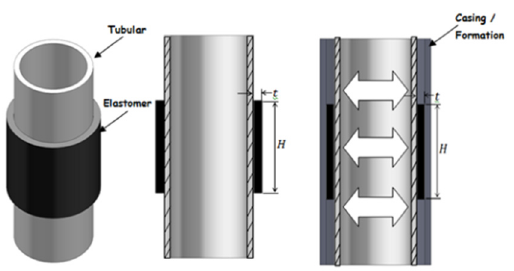
Figure 16. Schematic diagram of a typical expandable